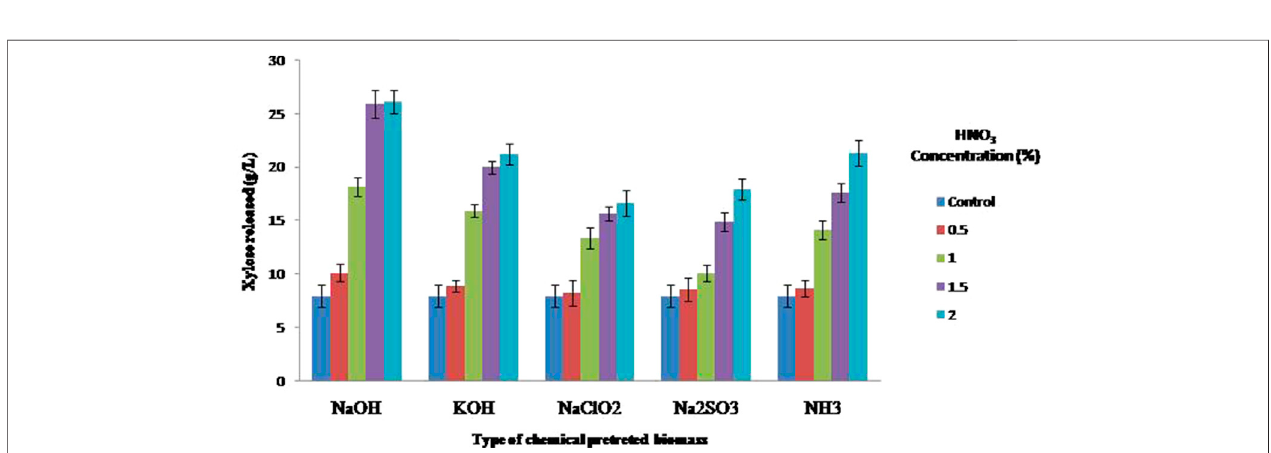
FIGURE 4 | Xylose released during the dilute acid sacchari fi cation of different alkali-based pretreated corn cob residues.